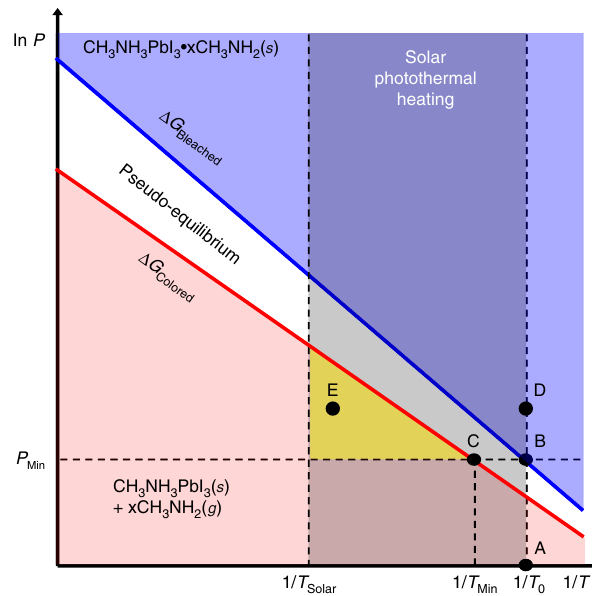
Fig. 2 Thermodynamic model of complex formation and dissociation. The Clausius – Clapeyron diagram describes the pressure – temperature ( P – T ) dependence of CH 3 NH 3 PbI 3 • x CH 3 NH 2 ( s ) formation and dissociation into CH 3 NH 3 PbI 3 (s) + CH 3 NH 2 (g). Points labeled A — E are described in the text. P • x CH Min indicates the minimum pressure needed for CH 3 NH 3 PbI 3 3 NH 2 formation at room temperature ( T 0 ). T Min is the minimum temperature needed for phase transition at P Min . The shaded region indicates temperatures attainable by solar photothermal heating up to the maximum temperature, T Solar . The yellow region indicates the necessary phase space for achieving switchable PV with solar photothermal Δ S ’ s energy change, enthalpy change, and entropy i are the Gibb change, respectively. The subscript i corresponds to the formation of the complexed bleached state or dissociated colored state.